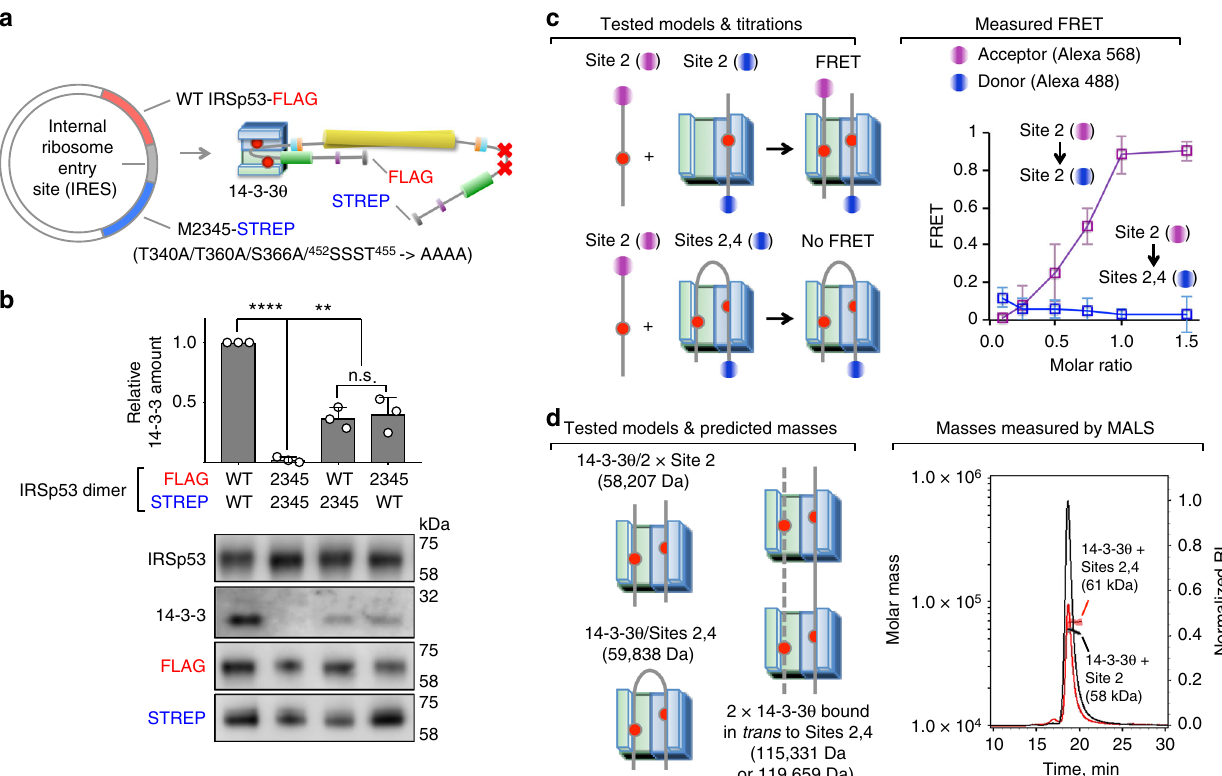
Fig. 3 Each subunit of the pIRSp53 dimer binds one 14-3-3 dimer. a Illustration of the strategy used to obtain wild-type/mutant IRSp53 heterodimers using dual af fi nity puri fi cation tags (FLAG and STREP) and an internal ribosomal entry site (IRES) inserted between the wild-type and mutant coding sequences of a single expression plasmid. The mutant M2345 carries seven S/T- > A substitutions (T340A/T360A/S366A/ 452 SSST 455 - > AAAA). b Coimmunoprecipitation of 14-3-3 with homo- and heterodimers of wild-type and mutant IRSp53. Two different heterodimers were tested, where the mutant subunit either preceded or followed the IRES, which also changed the puri fi cation tag. Abundance is reported relative to the amount of endogenous 14-3-3 that coimmunoprecipitates with WT-IRSp53-FLAG/WT-IRSp53-STREP. Error bars are ± s.d. from three independent experiments, shown as open circles. The statistical signi fi cance of the measurements was determined using an unpaired two-sided Student ’ s t -test, comparing each of the samples to wild-type IRSp53 (ns, non-signi fi cant; ** p < 0.01; **** p < 0.0001). c FRET assay in which acceptor (Alexa 568)-labeled Site 2 peptide was titrated into 14-3- 3 θ half-saturated (1:0.5 molar ratio) with donor (Alexa 488)-labeled Site 2 (magenta squares) or Sites 2,4 peptides (blue squares). FRET is only observed when the acceptor-labeled peptide binds to one of the pockets of the 14-3-3 θ dimer while the other pocket is occupied by donor-labeled peptide (as depicted on the left). Error bars are ± s.d. from three independent experiments. d Determination of the masses of complexes of 14-3-3 θ with Site 2 (black line) or Sites 2,4 (red line) peptides using SEC-MALS. The tested interaction models and corresponding masses are shown on the